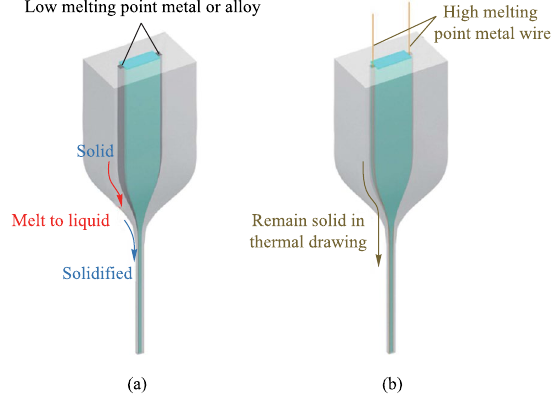
Fig. 5 Illustrations of sending electrodes into fibers in the thermal drawing process. a Low melting point metals or alloys, b high melt- ing point metal